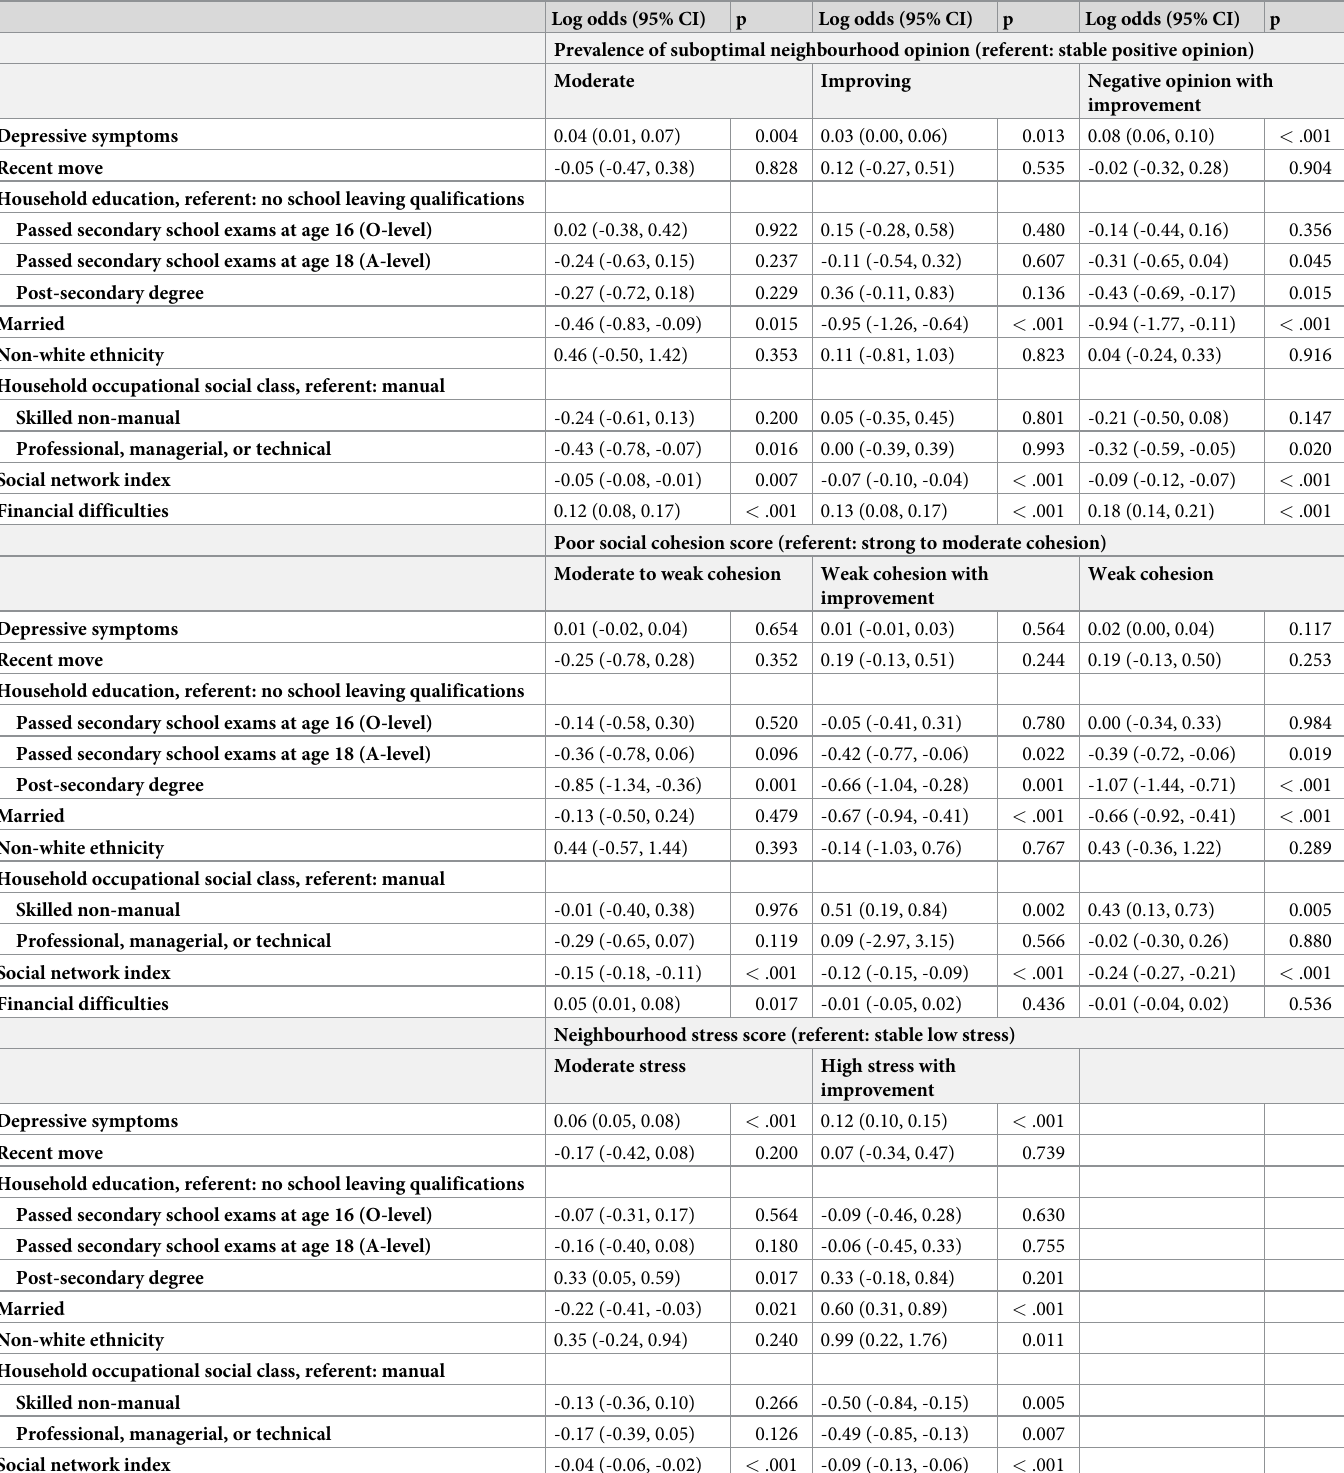
Table 6. Covariates associated with trajectory group membership for perceived measures of neighbourhood